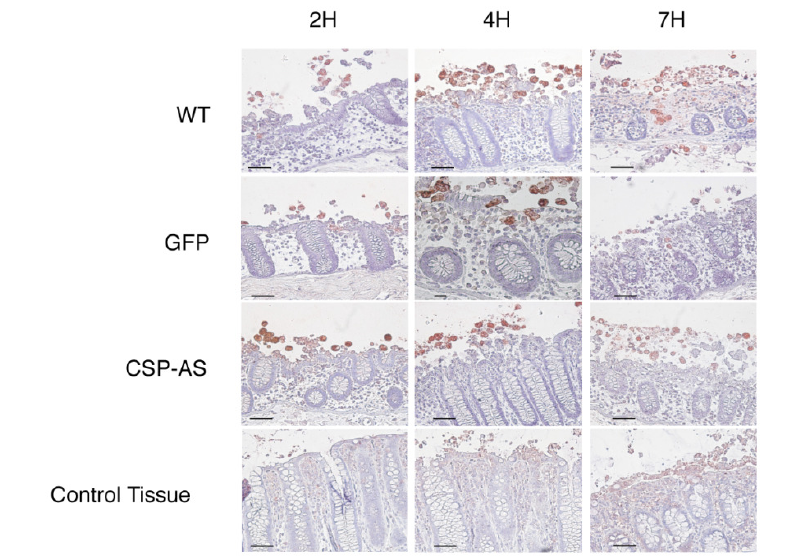
FIGURE 6: Invasion of ex vivo colonic ex- plants was impaired for CSP-AS trophozo- ites. Histological examination of colonic tissue sections after 7 h of infection with E. histolytica WT, GFP, CSP-AS strains and in the absence of trophozoites (control). Tis- sue cross-sections were stained with hema- toxylin/eosin reagent. Trophozoites were revealed with an antibody against Gal/GalNAc lectin and appear in red. WT and GFP trophozoites were able to invade the mucosa. In contrast, trophozoites ex- pressing the CSP-AS construct were unable to invade the lamina propria and tended to remain at the surface of the mucosa. Imag- es are representative of three individual experiments. Scale bar: 10